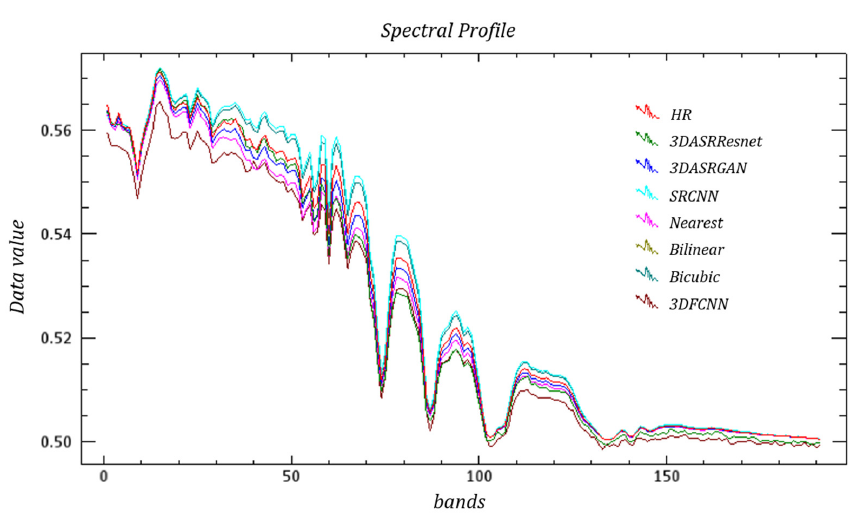
Figure 10. Example Spectral Curves of Roof based on Washington DC Mall dataset.